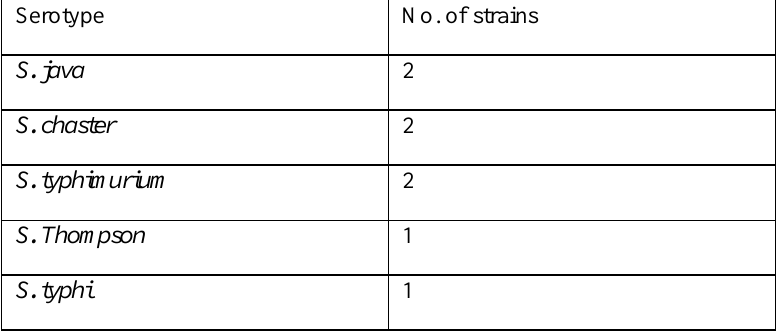
Table ( 4) serotypes isolated of Salmonella from Buffalo owners Serotype